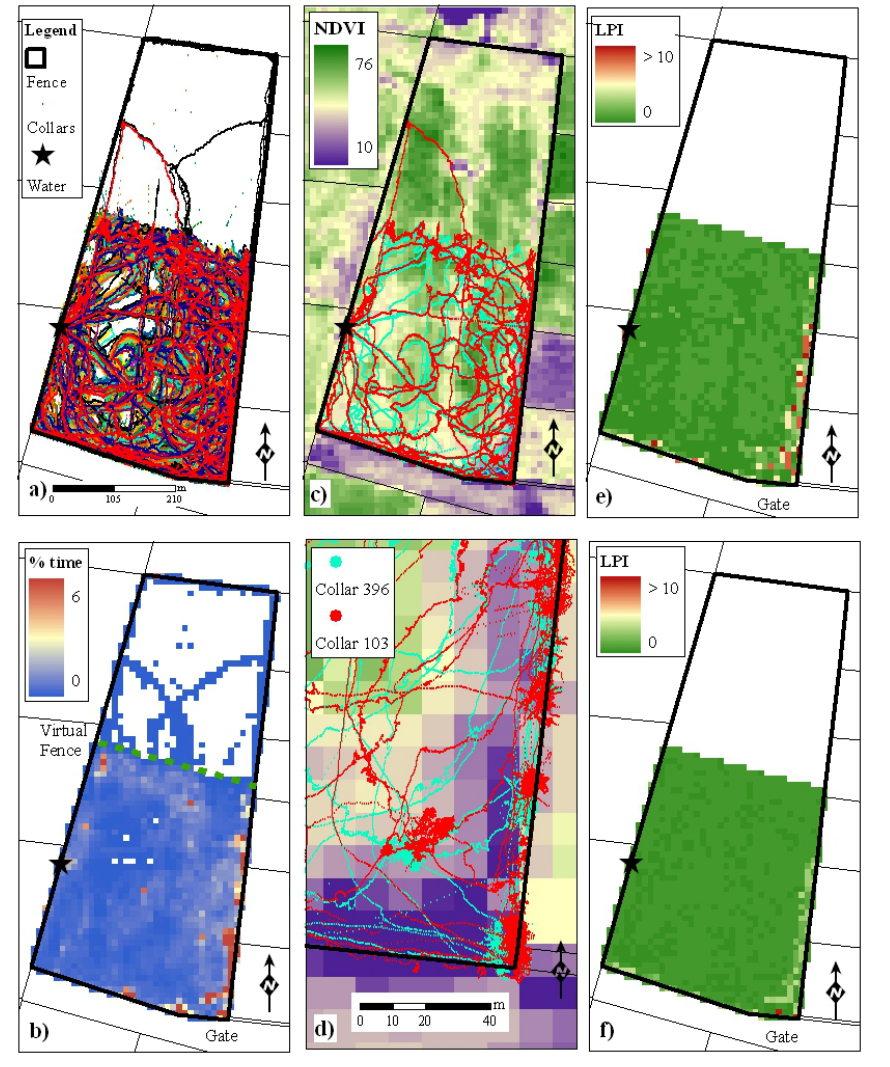
Figure 6. (a) The trajectories of 36 animals over three days in a paddock at Belmont Research Station. (b) Percentage of time during the experiment animals spent in each pixel. (c) Trajectories of two animals overlaid on satellite-derived NDVI values. (d) Same as (c) zoomed into the bottom right corner of the paddock. (e) LPI for each pixel in front of the fence based on the proportion of NDVI in this area for animal number 103. (f) Same as (e) for animal number